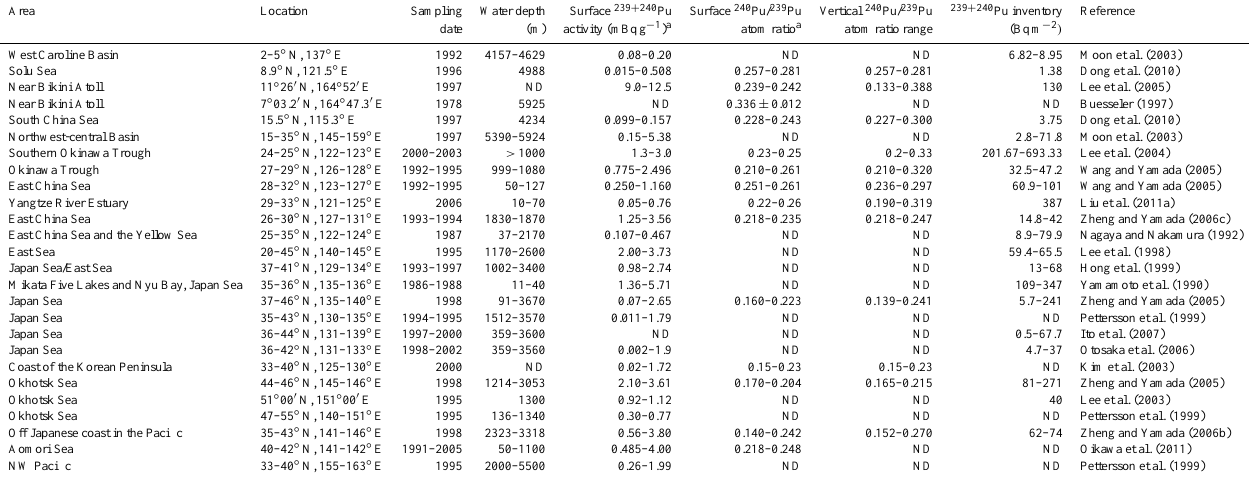
Table 2. Summary of the distributions of 239 + 240 Pu activity and 240 Pu/ 239 Pu atom ratio in sediments from the western North Pacific and its marginal